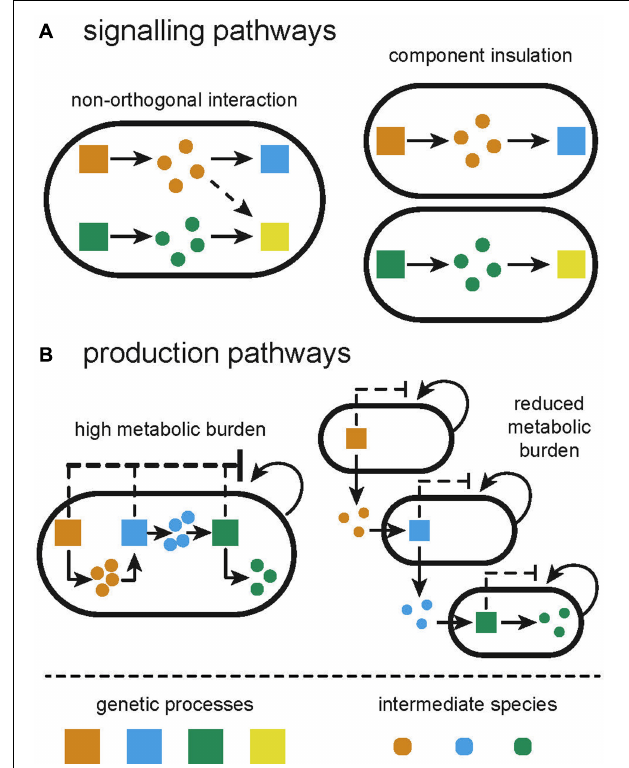
FIGURE 1 | Illustration of the limitations of monocultures and how they are overcome by constructing distributed systems from multiple cell types. (A) Signaling pathways in monocultures can often suffer from unintended and unexpected crosstalk between processes. Compartmentalizing independent functions in separate subpopulations will prevent crosstalk. (B) Applications in biosynthesis suffer from high metabolic burden due to the expression of multiple heterologous processes. Division of labor between multiple subpopulations can alleviate the metabolic